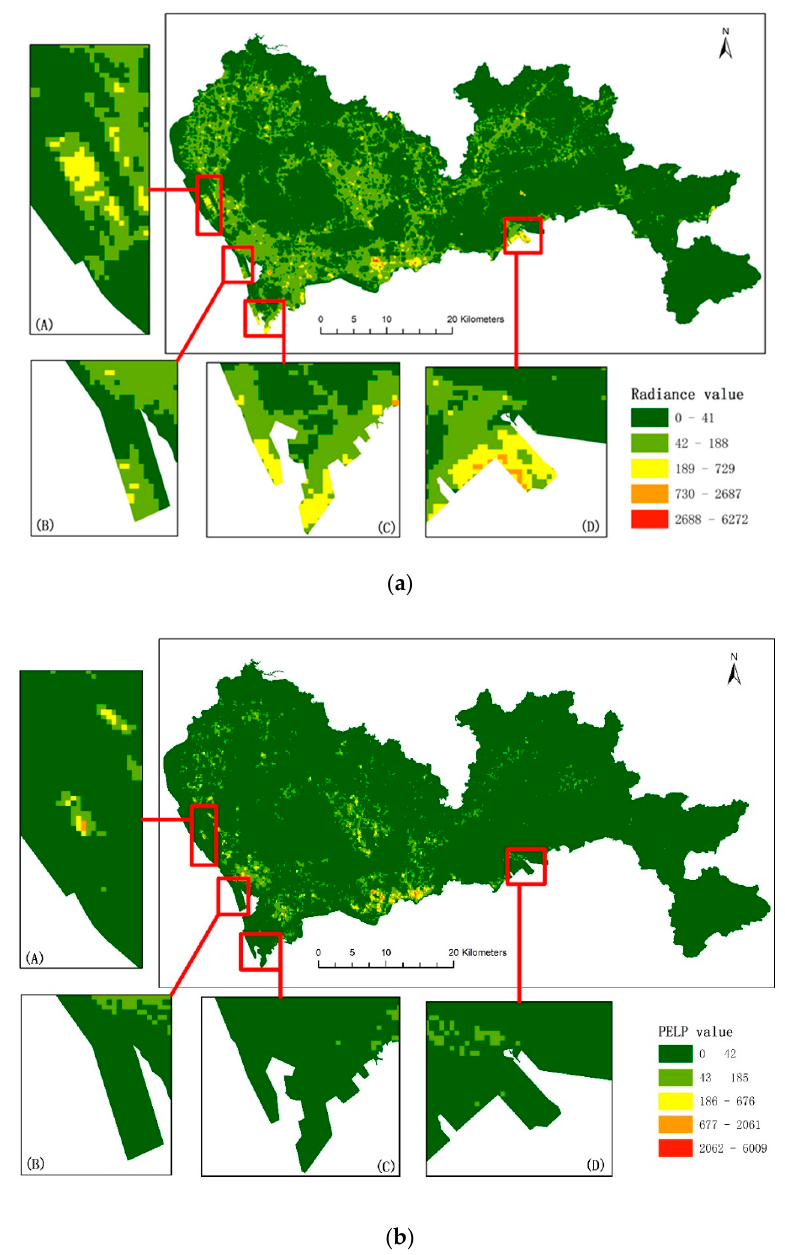
Figure 6. Comparison between the light pollution parameters based on nighttime light (NTL) radiance ( a ), and PELP ( b ), typical regions including (A) Shenzhen International Airport, (B) Dachanwan Port, (C) Shekou Cruise Port, and (D) Yantian Port.